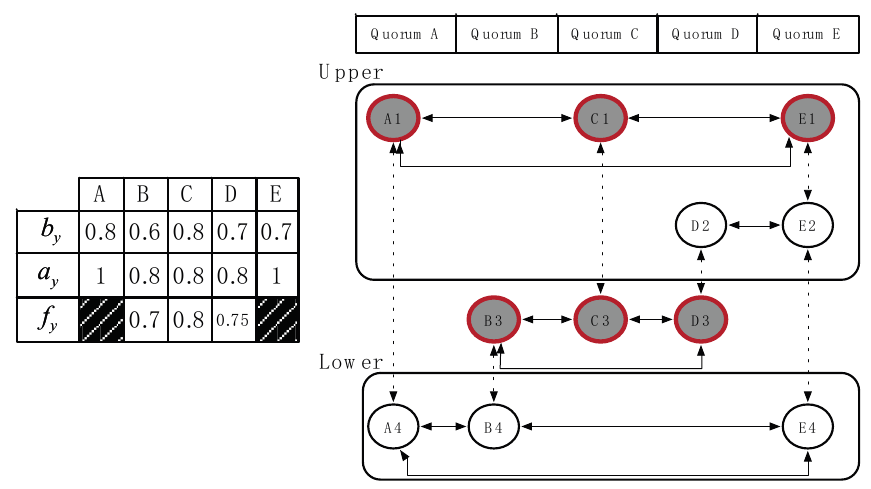
Figure 5. Two parts of WQS method.